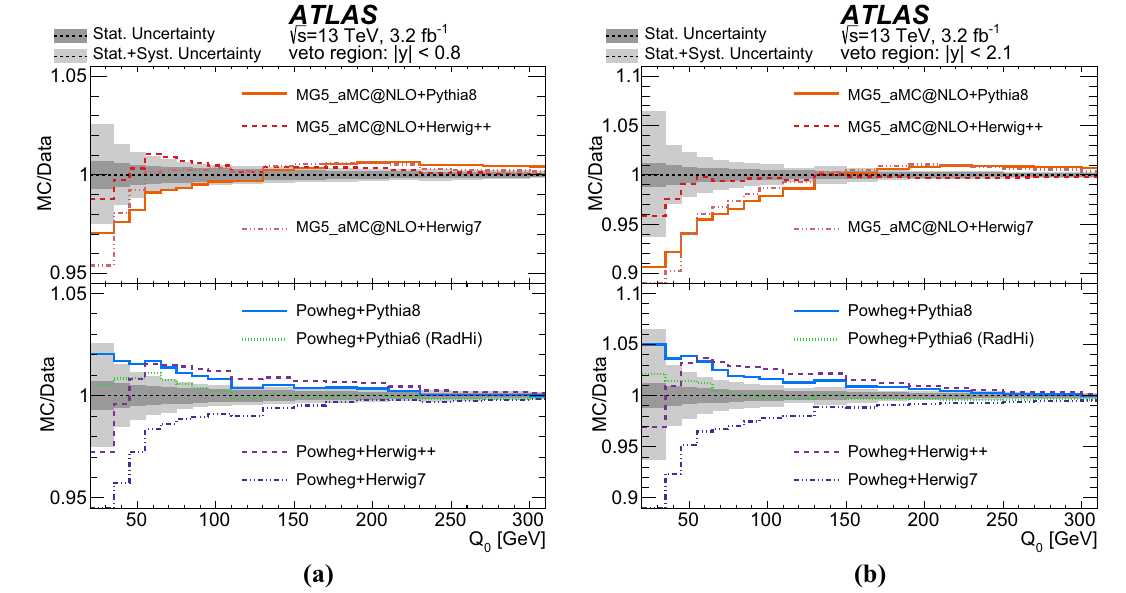
Fig. 10 Ratios of prediction to data of the measured gap fraction f part gap ( Q 0 ) as a function of Q 0 in different rapidity veto regions, a | y | < 0 . 8 and b | y | < 2 . 1. The predictions from various t ¯ t simulation